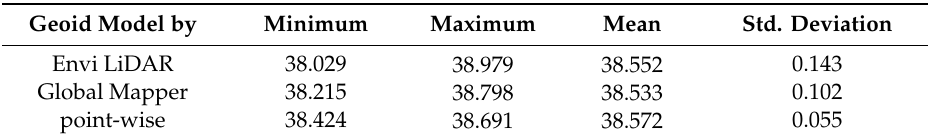
Figure 12. After removing blunders with 1- σ test: The gridwise local geoid surfaces generated using DTMs by ( a ) Envi LiDAR and ( b ) Global Mapper and ( c ) the pointwise local geoid surface (interpolated from Global Mapper grid-wise geoid model in geoid control points and gridded by Surfer software Kriging approach). Table 3. After removing blunders with 1- σ test: the statistics of calculated geoid heights from models using Envi LiDAR and Global Mapper software over the whole test site and point-wise geoid heights interpolated from Global Mapper grid-wise solution (m).